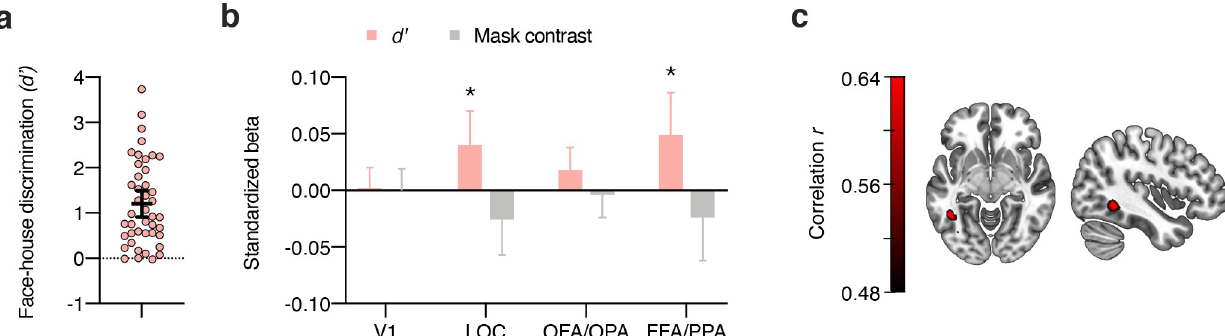
Fig 5. Blindsight-like discrimination of subjectively invisible stimuli. (a) Perceptual discrimination of subjectively invisible stimuli (d’) was highly variable between individuals. Every circle represents a participant; the horizontal bar the mean, and the error bar the 95% confidence interval. (b) Multiple regression analyses of category information ( Δ r ) in the four ROIs for the subj-inv condition, showing standardized beta weights for the predictors perceptual discrimination of subjectively invisible stimuli (d’) and mask contrast in the subj-inv condition. Error bars show 95% confidence intervals. � p < 0.05 �� p < 0.01. (c) Partial correlation between perceptual discrimination and the subj-inv whole-brain searchlight, adding the effect of mask contrast to the null model. Note that this map is thresholded at p < 0.001, uncorrected. Data underlying this figure are available on OSF (https://osf.io/qus5v/). FFA, fusiform face area; LOC, lateral occipital complex; OFA, occipital face area; OPA, occipital place area; area; PPA, parahippocampal place area; ROI, region of interest; subj-inv, subjectively invisible; V1, primary visual cortex.